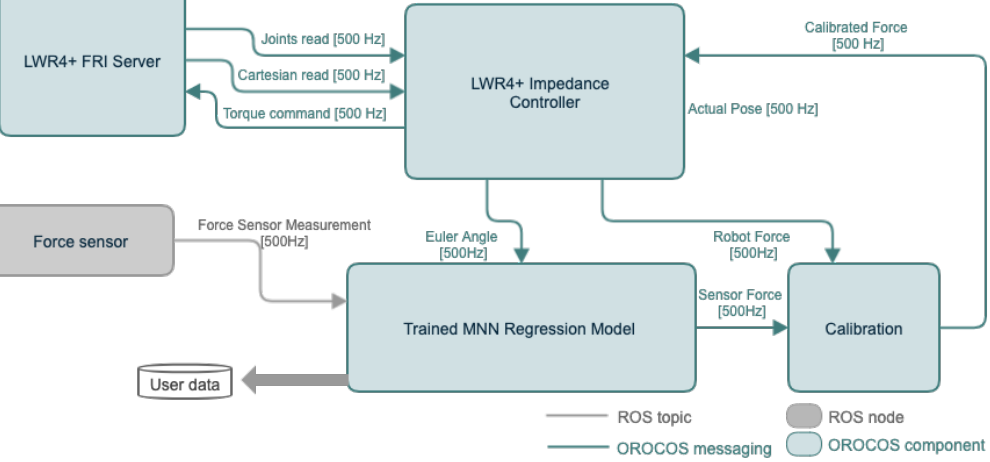
Figure 8. Overview of the developed software system. The “LWR4+ Impedance Controller” is adopted to allow hands-on control to move the surgical robot arm by hands. The “force sensor” is developed using Robot Operating System (ROS) and it communicate with the Open Robotic Control Software (OROCOS) by ROS topic with a frequency of 500